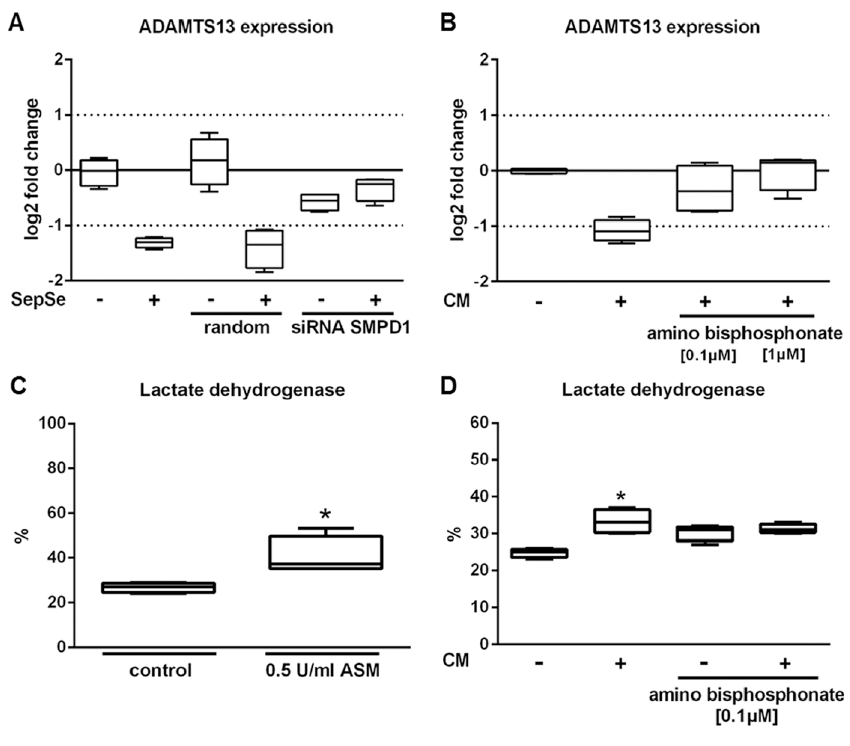
Figure 5. Detrimental role of SMPD1 in sepsis-induced endothelial stress response Semi-confluent HMECs (1 × 10 4 ) were incubated for 24 h with serum (5%) obtained from healthy individuals, from patients with sepsis (n = 6) or proinflammatory cytokines. Co-incubation with (A) SMPD1 specific siRNA (5 nmol/L, preincubation for 48 h) or (B) SMPD1 direct inhibitor amino bisphosphonate (0.1 μmol/L) prevented ADAMTS13 down- regulation as normalized to reference transcript GAPDH . Stimulation of HMECs with (C) isolated human acid sphingomyelinase resulted in significant LDH release into the super- natant, whereas (D) amino bisphophonates abrogated LDH release following cytokine stimulation. The boxes indicate the interquartile range, divided by the median (central horizontal line) as analyzed in at least four independent